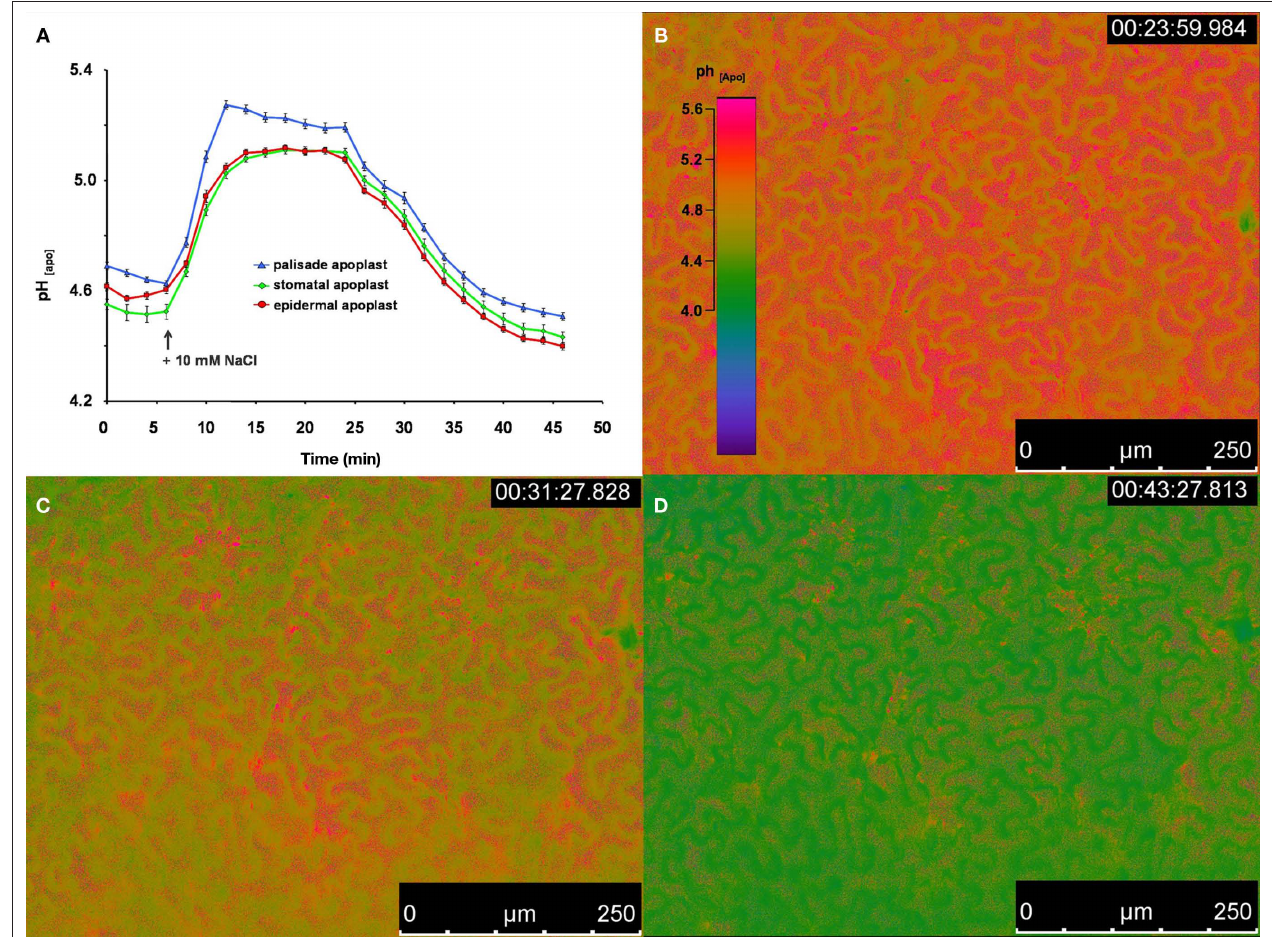
Figure 4 | ratiometric real-time quantitation of leaf apoplastic pH in response to the addition of 50 μL of a 10 mM NaCl solution onto the leaf. (A) pH as recorded at the adaxial face of Vicia faba leaves is plotted over time. Black arrow indicates the time of the addition of the 10 mM NaCl stress stimulus onto the surface of the leaf. Leaf apoplastic pH was discriminated within three apoplastic components, viz. in the stomatal cavity ( n = 10 ROI; green kinetic; mean ± SE of ROIs), in the epidermal apoplast ( n = 20 ROI; red kinetic;